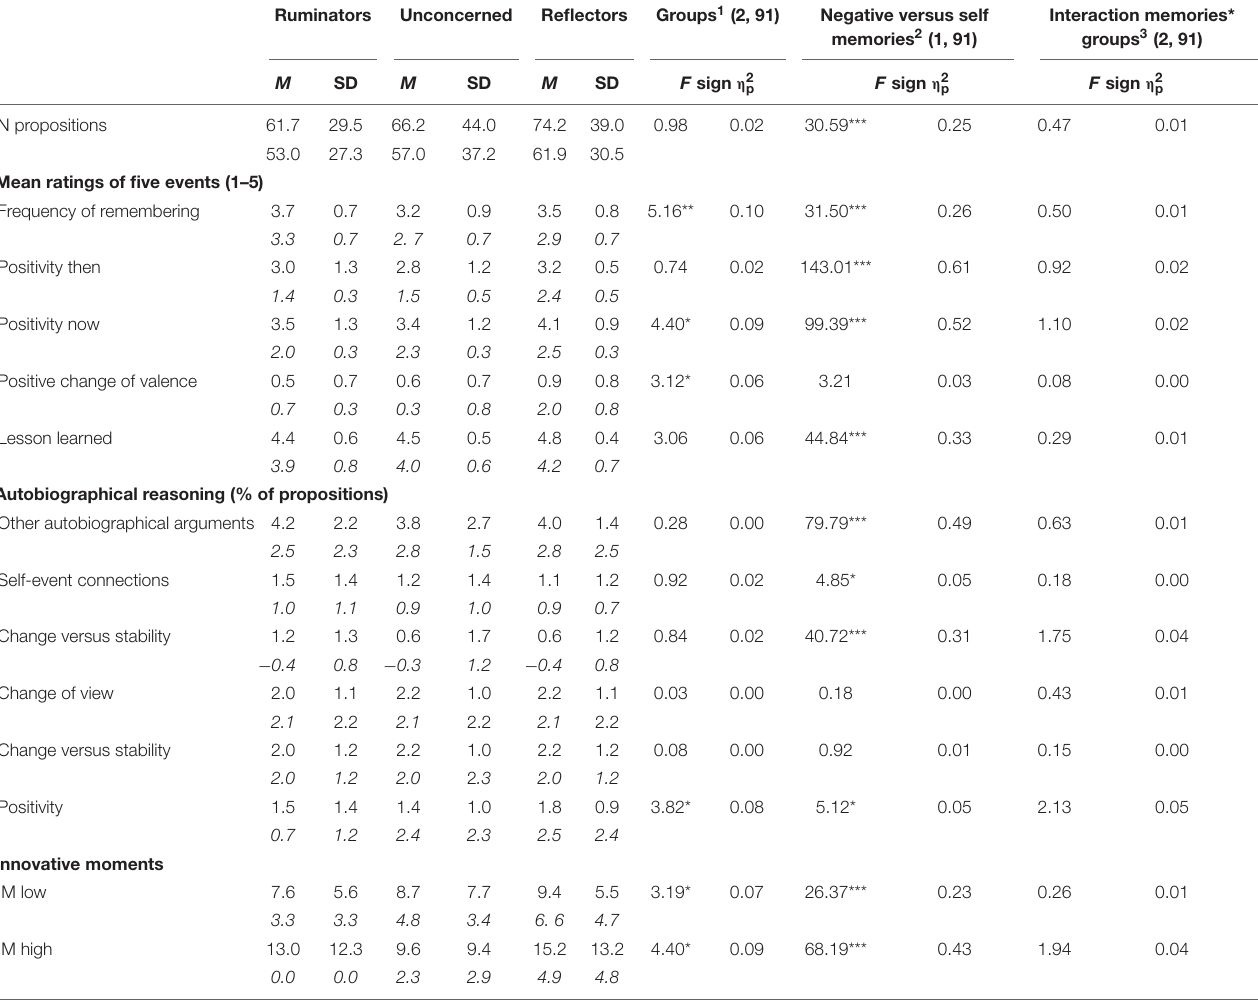
TABLE 2 | Narrative characteristics of ruminators, unconcerned, and reflectors, for two self-relevant memories (upper lines) and three negative memories (lower lines). Ruminators